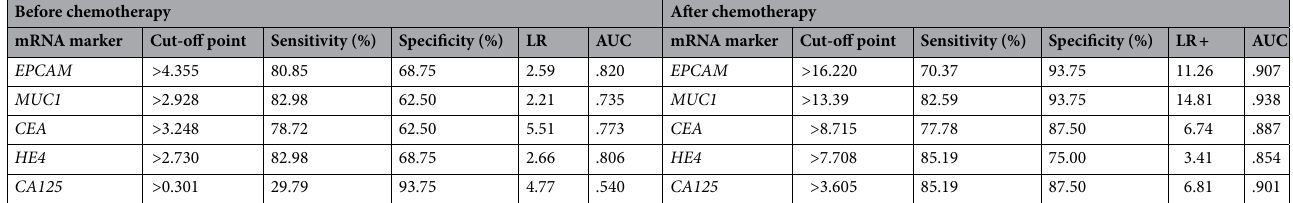
Table 3. The sensitivity, specificity, LR and AUC of ROC of EPCAM , MUC1 , CEA , HE4 and CA125 markers in EOC patients before and after adjuvant chemotherapy.